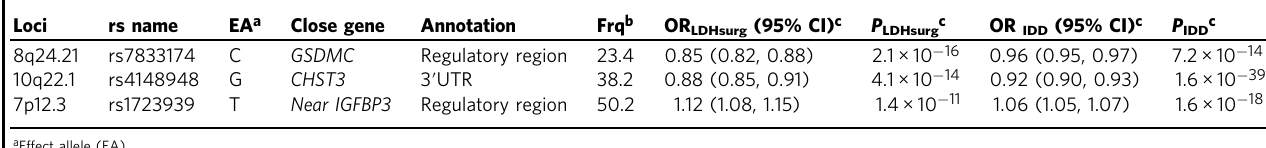
Table 2 Variants associating with LDHsurg in GWAS meta-analysis of three cohorts; Iceland, UK Biobank and Finland ( N cases = 9188, N controls = 780,323) compared to association with IDD (M51) in all four cohorts.